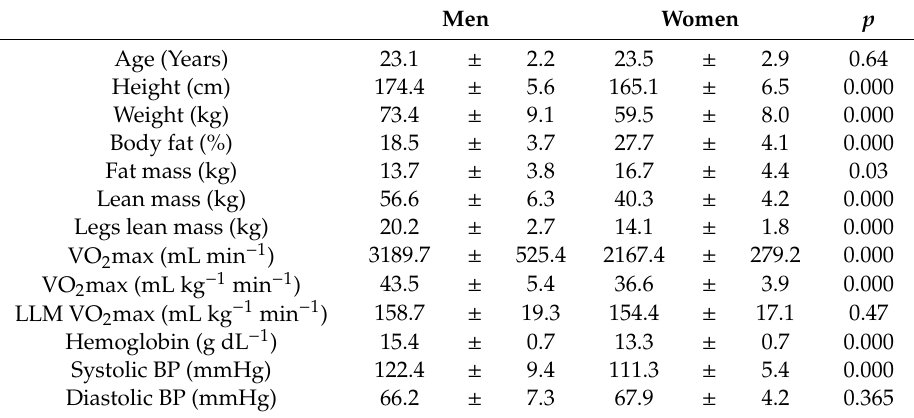
Table 1. Physical characteristics, body composition and VO 2